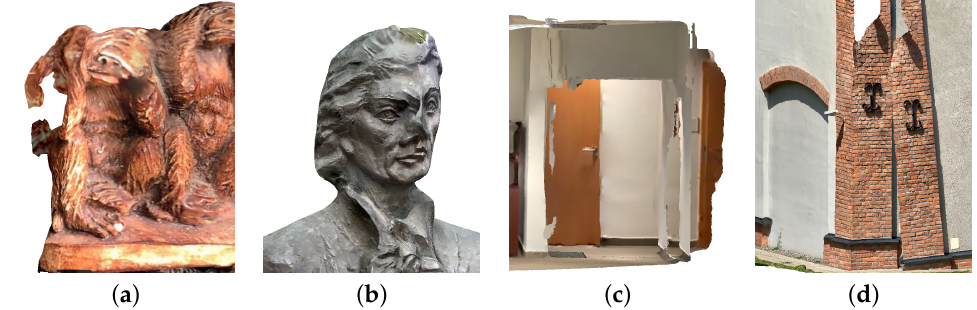
Figure 5. Common bugs in iPad meshes: ( a )—discontinuity and deformation, ( b )—deformation and displacement, ( c )—duplication, ( d )— duplication.